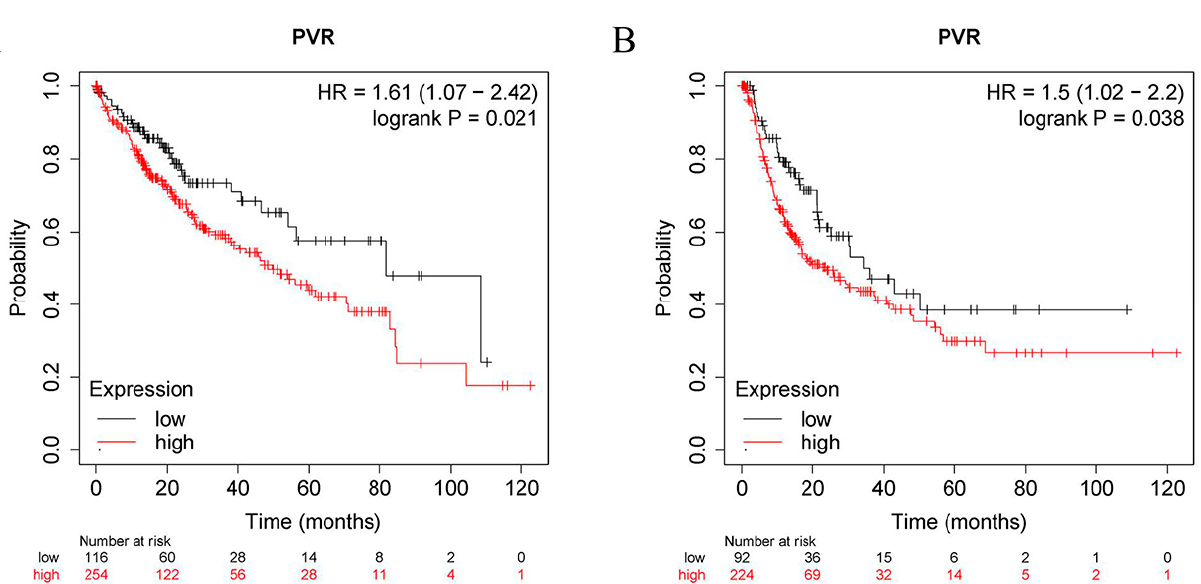
Figure 2. PVR expression in the GEO database. ( A ) PVR expression in the normal and tumor tissues in HCC from GSE64041. ( B ) ROC curve of PVR in HCC. * p < 0.05.